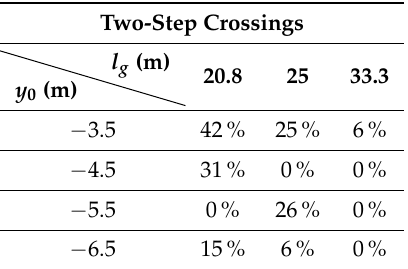
Table 3. Proportion of two-step crossings to all successful crossings for several values of y 0 and l g , when v c = 30 km/h and vehicle type is